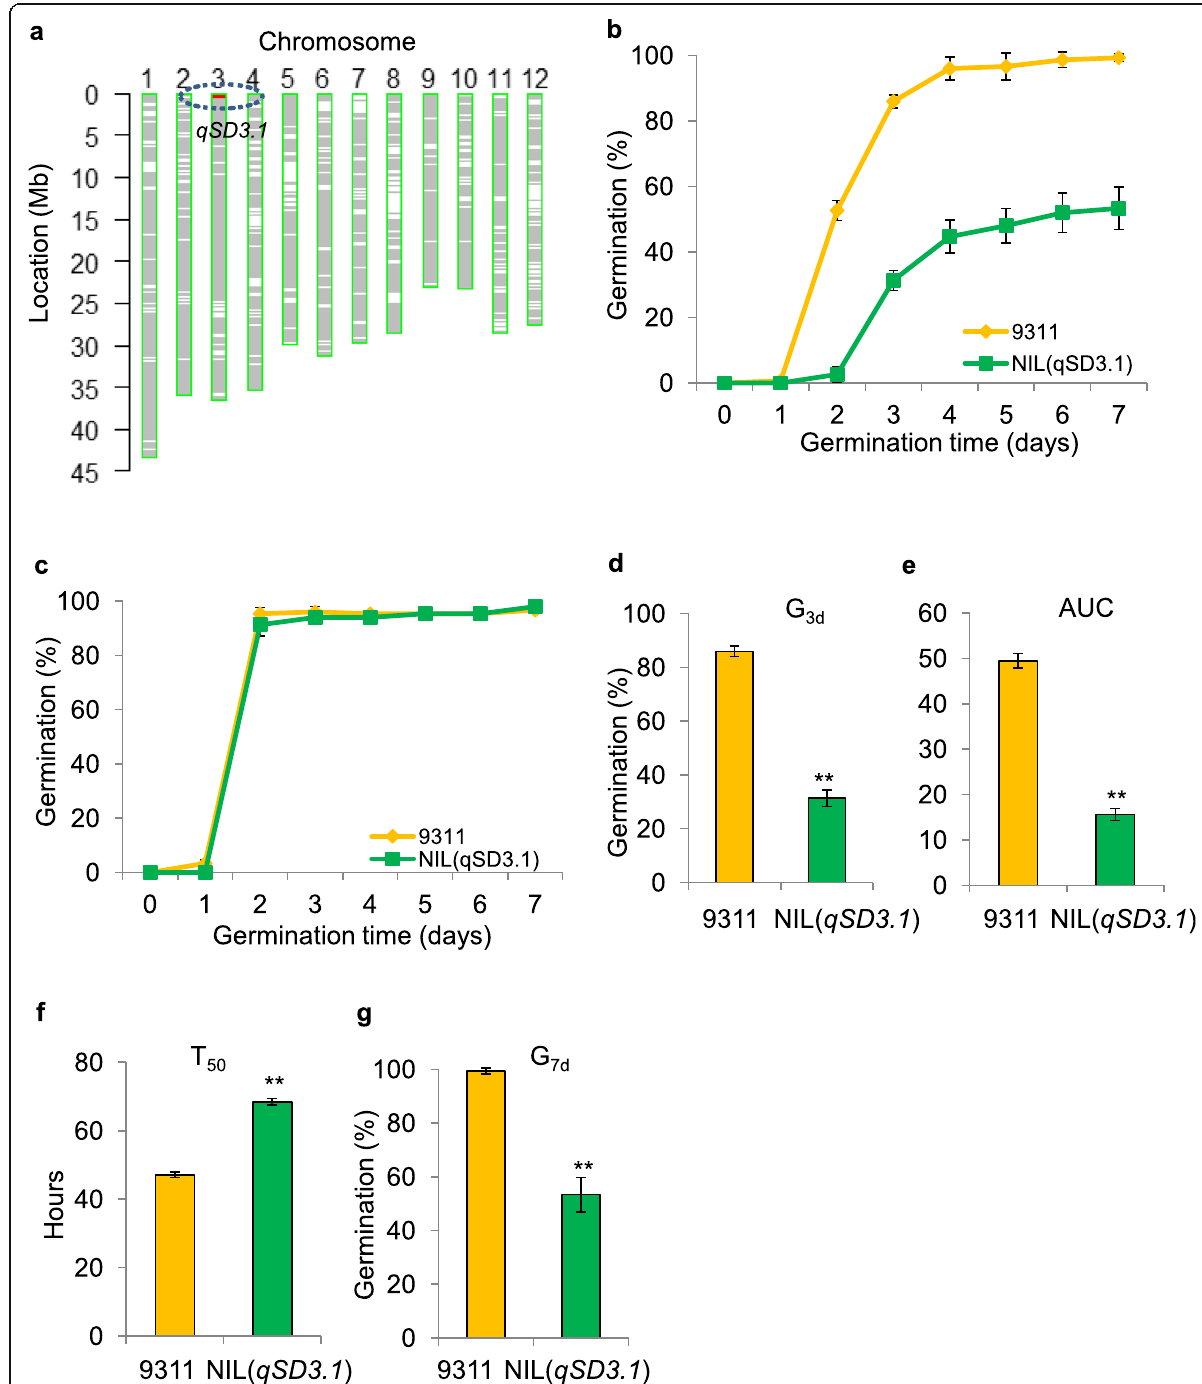
Fig. 4 Validation of the effect of qSD3.1 on seed dormancy. a Graphical genotype showing NIL ( qSD3.1 ) that carries a single introduced Nipponbare segment encompassing qSD3.1 . The red and green bars represent the Nipponbare segment and the 9311 background, respectively. b Germination curve of freshly harvested seeds of NIL ( qSD3.1 ) and 9311. c Germination curve of NIL ( qSD3.1 ) and 9311 seeds after dormancy breaks. d-g Germination behaviors of NIL ( qSD3.1 ) and 9311; G 3d ( d ), AUC ( e ), T 50 ( f ) and G 7d ( g ). G 3d , germination rate at 72 h after imbibition; G 7d , maximum germination rate at 168 h after imbibition; T 50 , germination speed, which is the time to reach 50% germination of seeds; and AUC, the area under the curve up to 168 h after imbibition. The error bar represents the mean ± SD ( n = 3). Double asterisks indicate significant differences at P <